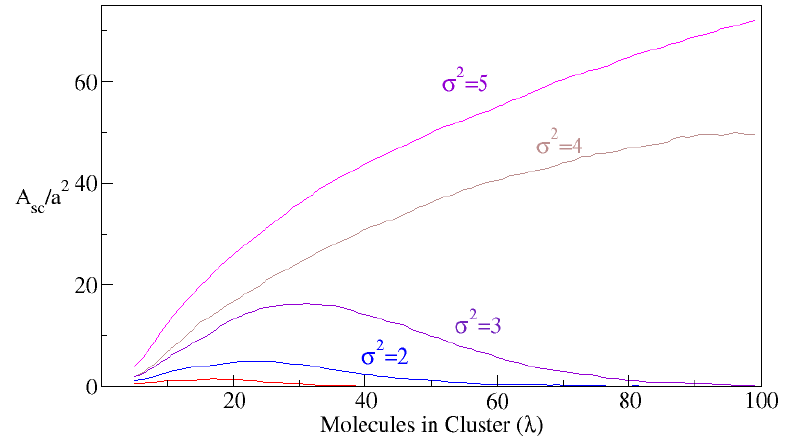
Figure 9. Average contact surface area between the largest cluster and a substrate as a function of the order parameter λ for different roughnesses with ξ = 20: from lower to upper curve σ 2 = 1, 2, 3, 4, and 5.